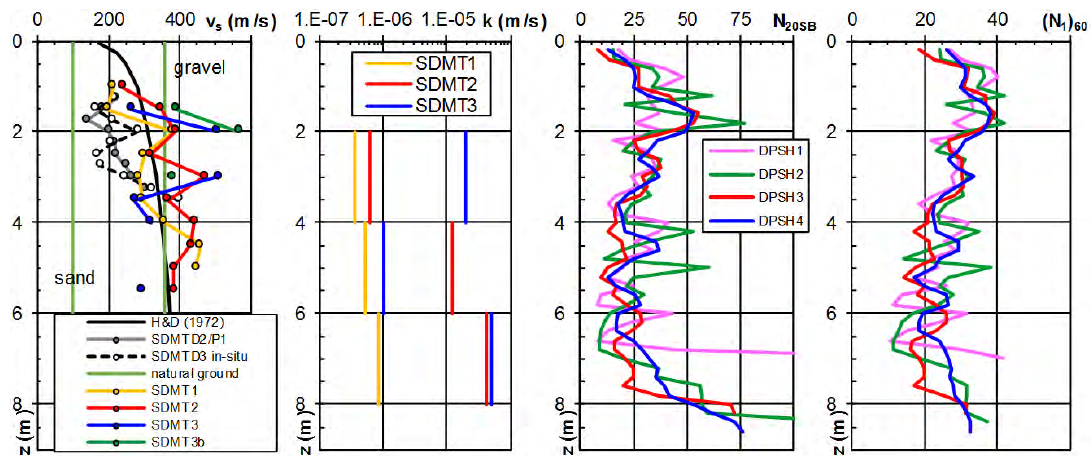
Figure 28. Temporary dike. Shear wave velocity, hydraulic conductivity, and results of DPSH B (from left to right).